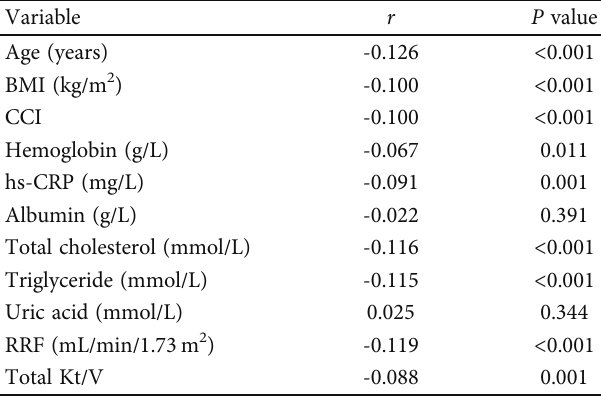
Table 2: Relationship of MPV/PC with relevant